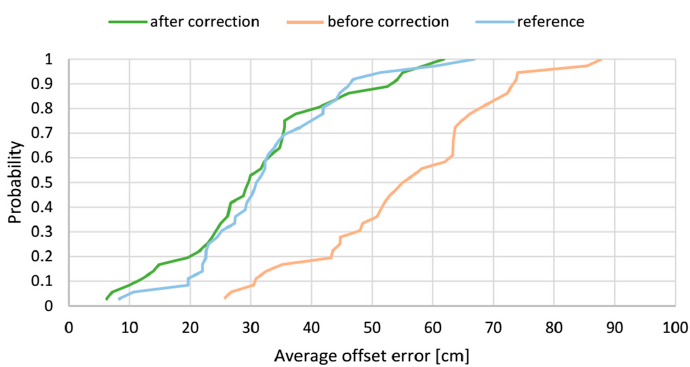
Figure 21. Experimental cumulative distribution functions of the average resultant offset error for LSs AB pair for three algorithms. AB pair for three